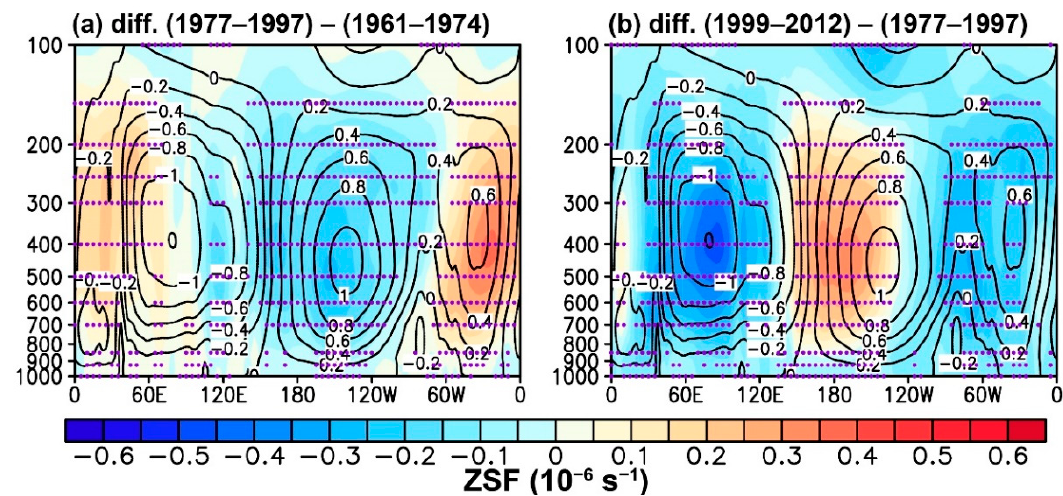
Figure 5. Contours in ( a ) and ( b ): mean state (1961–2012) of the annual mean zonal circulations along the equator (5° S–5° N); shading: differences in the annual mean zonal circulations between ( a ) the periods 1961–1974 and 1977–1997 and ( b ) the periods 1977–1997 and 1999–2012. The changes statistically significant at the 5% confidence level are dotted in purple.